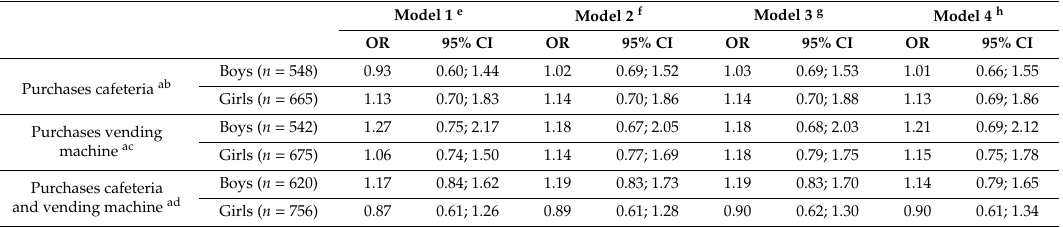
Table 6. Mixed logistic regression analyses on the e ff ect of a healthier canteen (ref. group not healthy) on changes in purchase